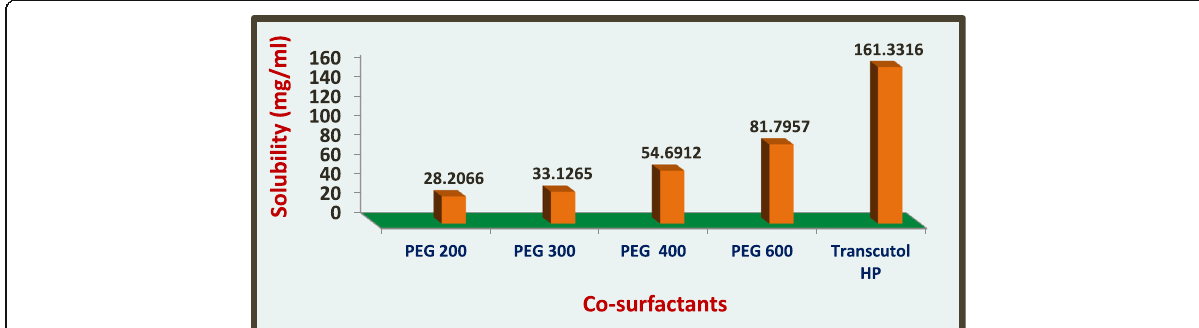
Fig. 3 Solubility study results of candesartan cilexetil in different co-surfactants